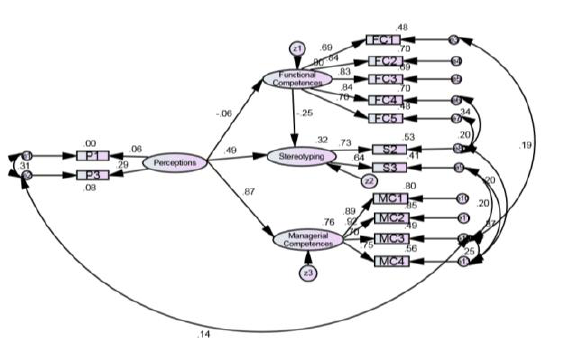
Figure 2: The structural model of the study